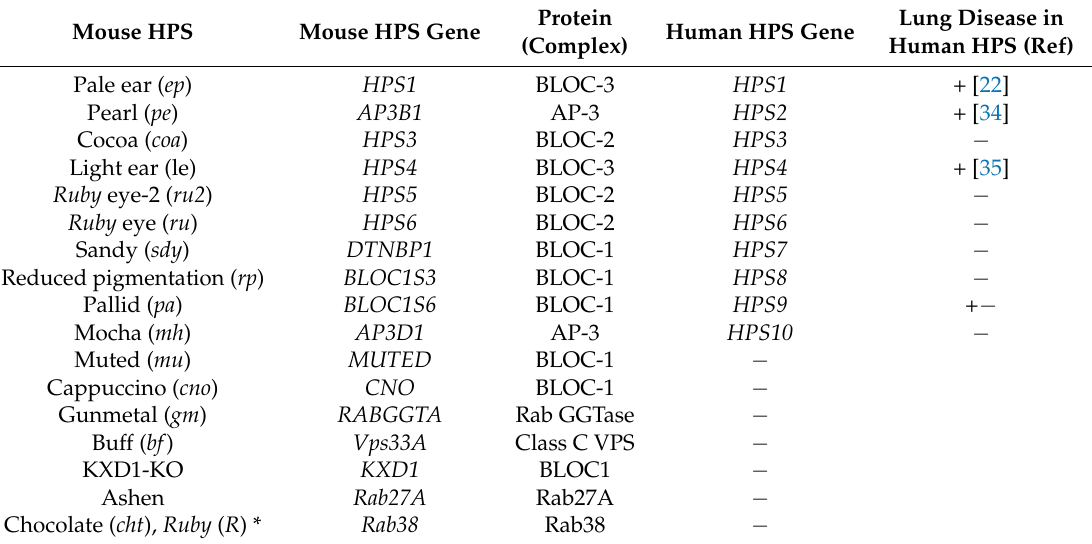
Table 1. Murine models of Hermansky-Pudlak syndrome and identified human homologs.